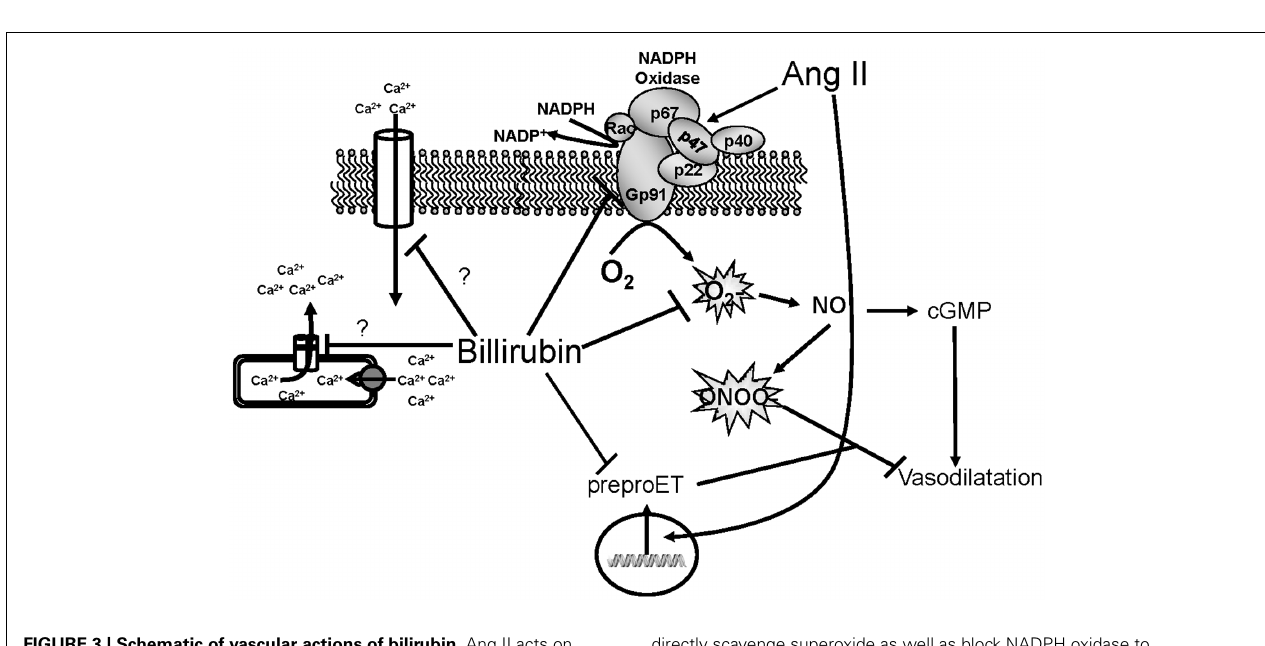
FIGURE 3 | Schematic of vascular actions of bilirubin. Ang II acts on the NADPH oxidase to increase superoxide production. Superoxide can then react with nitric oxide (NO) to form peroxynitrite which inhibits vasodilatation. Ang II can also stimulate the expression of